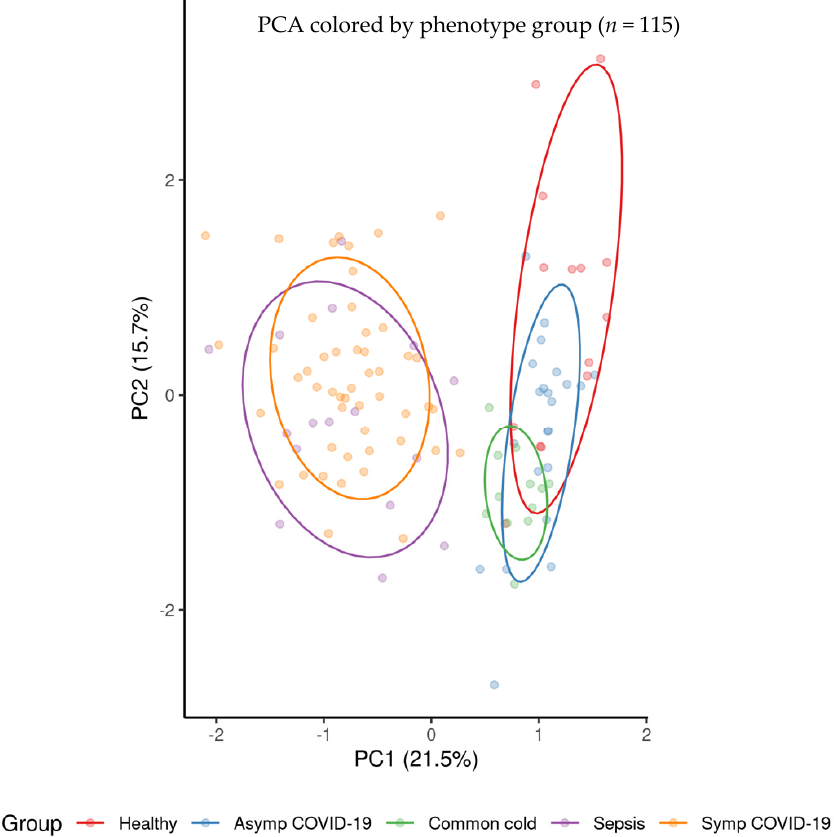
Figure 1. Visualization of top two principal components in PCA of all 115 subjects included in the analysis (subjects are colored by phenotype).